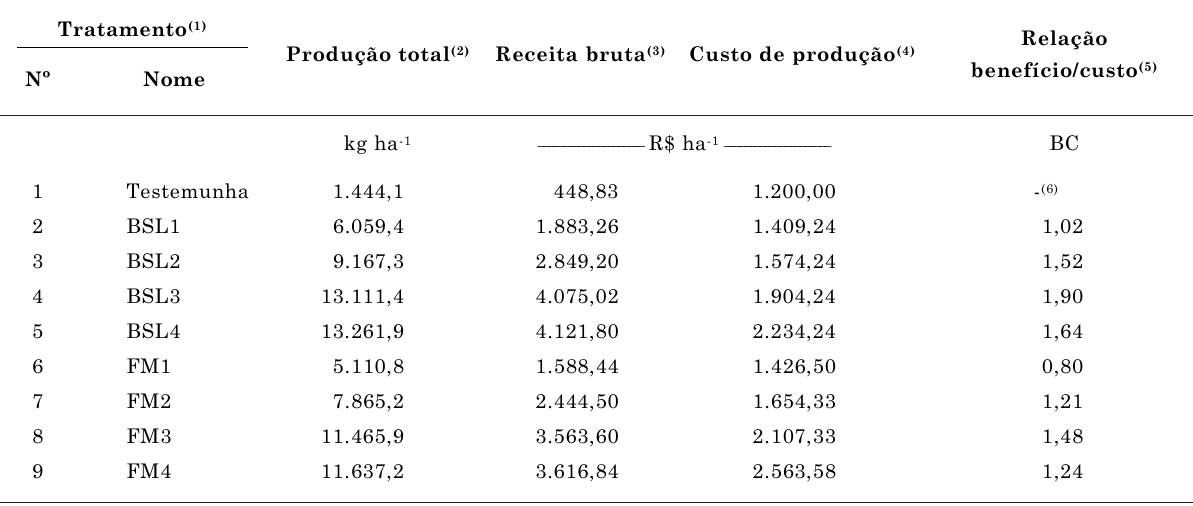
(1) Detalhes sobre os tratamentos ver quadro 1. (2) Somatório das produtividades de grãos do primeiro e do segundo cultivo. (3) Produção comercializada ao preço de R$18,65 sc -1 de 60 kg (base abril 2003). (4) Custo de insumos e serviços (R$600,00) para cada ano, mais o valor dos fertilizantes por tratamento. (5) Eq. 1: BC = (RP – RT)/CP, em que RP é receita de produção; RT é receita testemunha; e CP custo de produção. (6) Não